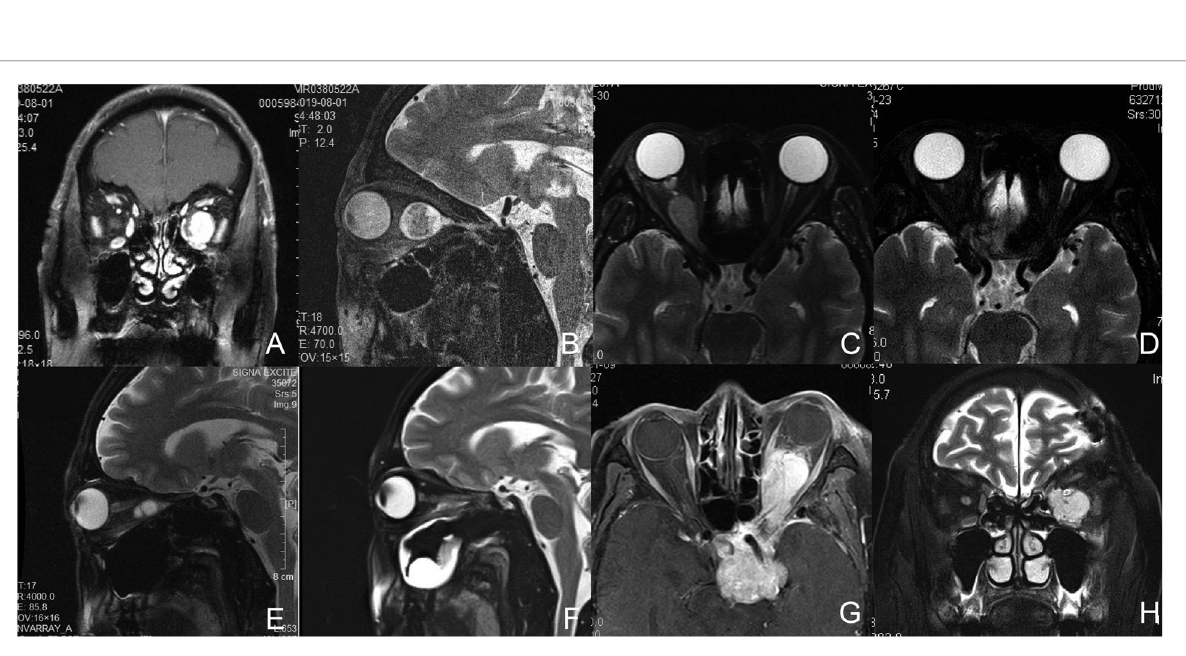
FIGURE 1 Magnetic resonance (MR) images of Patient1, 2, 3, and 5. ( A,B ) Preoperative coronal ( A ) and sagittal ( B ) T2-weighted images of Patient 1 with a left intraconal schwannoma medial to the optic nerve. ( C , D ) Axial T2-weighted images of Patient 2 with a right intraconal meningioma involving the intracanalicular segment of the optic nerve preoperatively ( C ) and 2 months postoperatively ( D ). ( E , F ) Sagittal T2-weighted images of Patient 3 with a right intraconal schwannoma preoperatively ( E ) and 2 months postoperatively ( F ). ( G , H ) Axial T1-weighted ( G ) and coronal T2-weighted ( H ) images of Patient 5 with a recurrent pituitary tumor involving the sellar region, suprasellar region, cavernous sinus, intraconal space, infratemporal fossa, and pterygopalatine